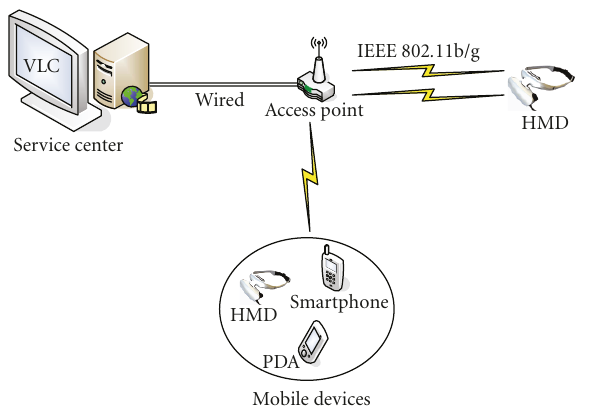
Figure 2: The whole test bed